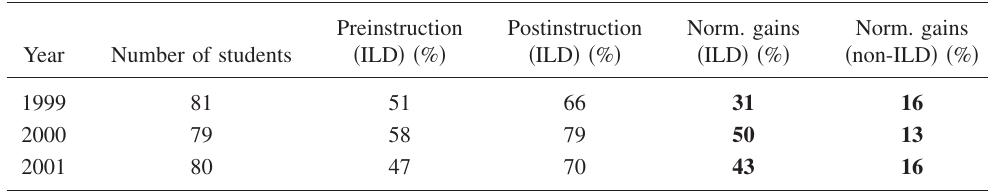
TABLE III. Average normalized gains for ILD teaching, compared with those of traditional teaching, 1999–2001.